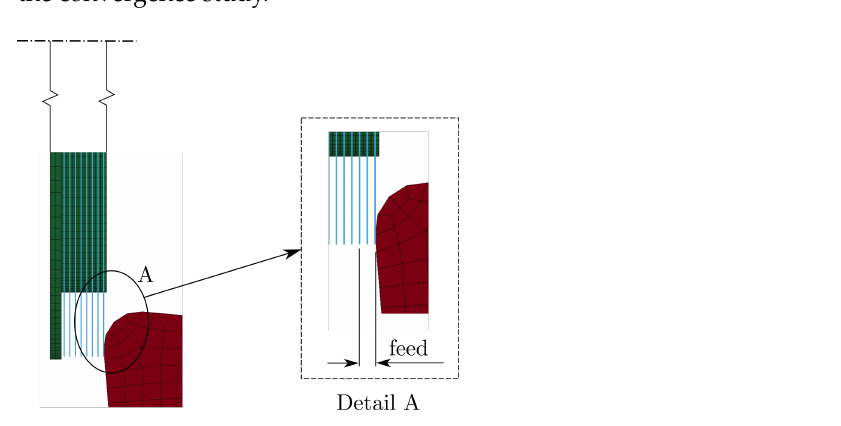
Figure 9. Terminology used for quantifying the number of SPH particles. This figure shows 2.0 par- ticles model. In one revolution of the workpiece, the tool feed equals two rows of SPH particles in axial direction.